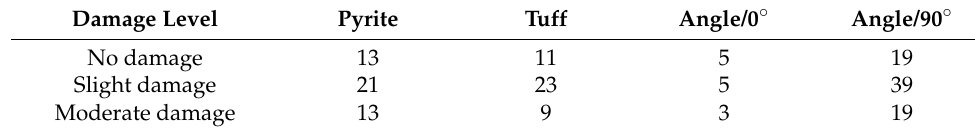
Table 4. Statistics results between the damage levels and the angle and